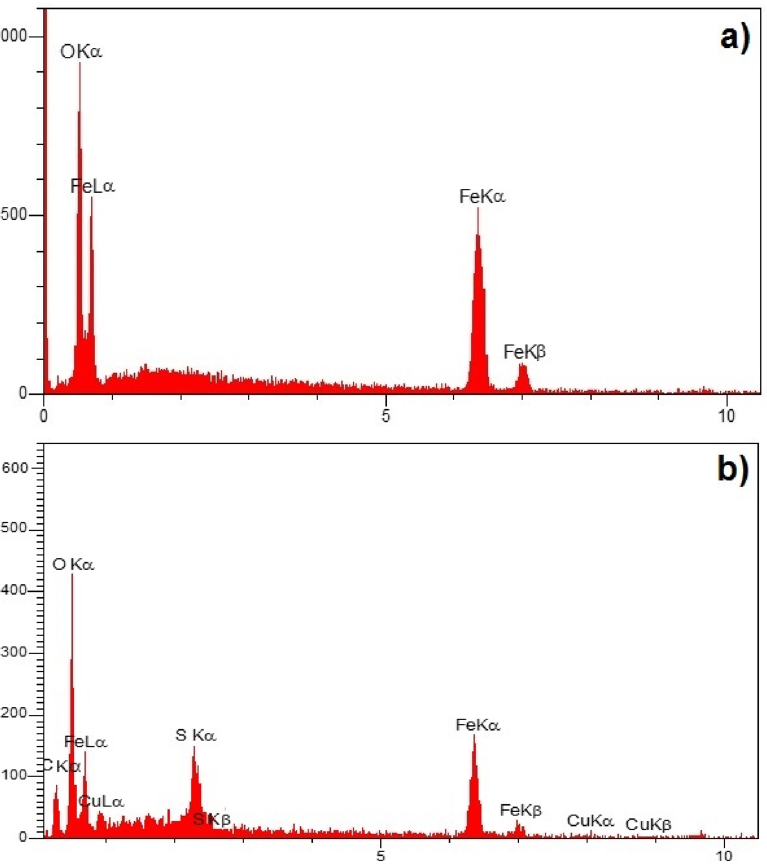
Figure 7. EDX patterns of ( a ) Fe 3 O 4 and ( b ) Fe 3 O 4